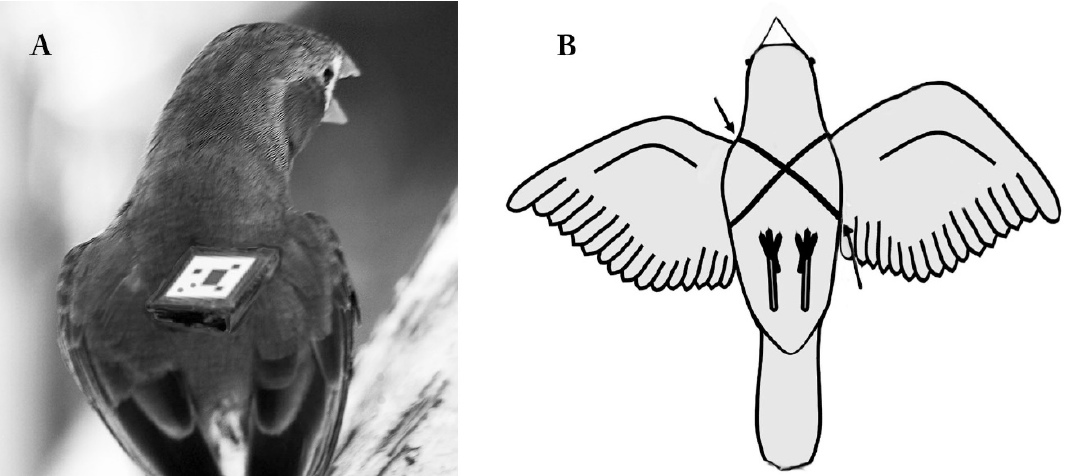
Figure 3. An automated barcode tracking system designed for behavioral studies of birds. ( A ) How an attached unit is affixed on a zebra finch’s back (adapted from Alarcón-Nieto et al., 2018 [238]). ( B ) Ventral view of the harness that holds the barcode device Note, the arrows facing down and up indicate particularly risky areas for inflammation, infection, or damage to skin or wings. (Photocredit: G.Kaplan- bar code is superimposed; approx.to scale)